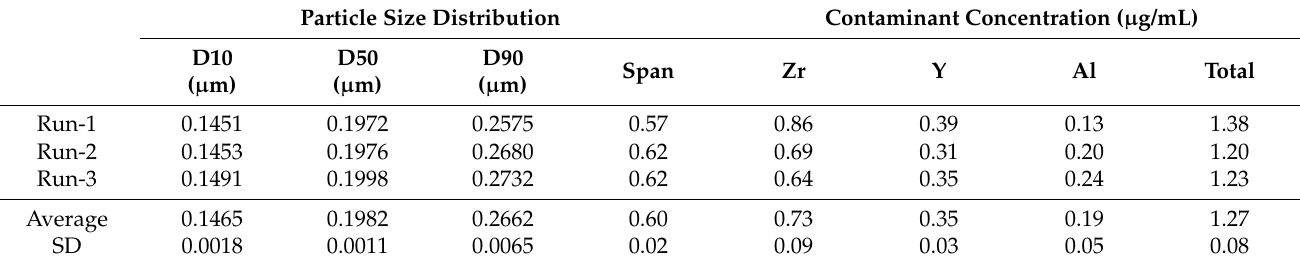
Figure 1. The particle size transition of the PHT as a function of the bead-milling time ( n = 3). ( A ) D50 and ( B ) D90. Bead milling was carried out for process validation. Table 2. The particle size and metal contamination at the target particle size during the process validation using PHT ( n =